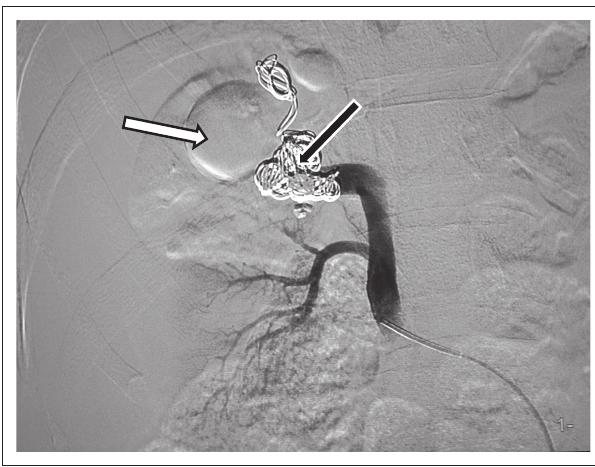
FIG URE 3: Angiogram demonstrating the arteriovenous malformation: The arterial feeder (black arrows) is shown communicating with the venous aneurysm (white arrow).